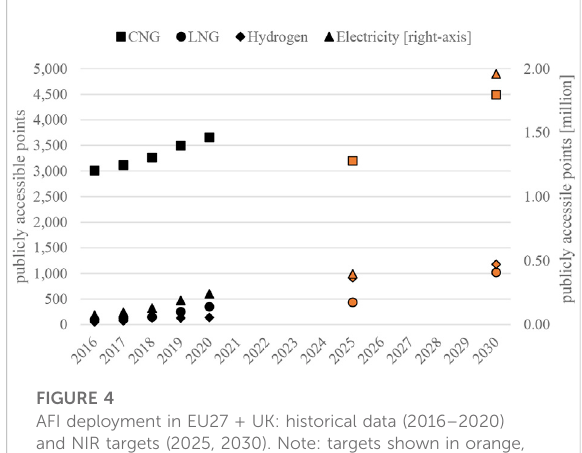
FIGURE 4 AFI deployment in EU27 + UK: historical data (2016 – 2020) and NIR targets (2025, 2030). Note: targets shown in orange, resulting from the sum of the available targets. Source: adapted from EC (2022), based on NIR and EAFO (2021)